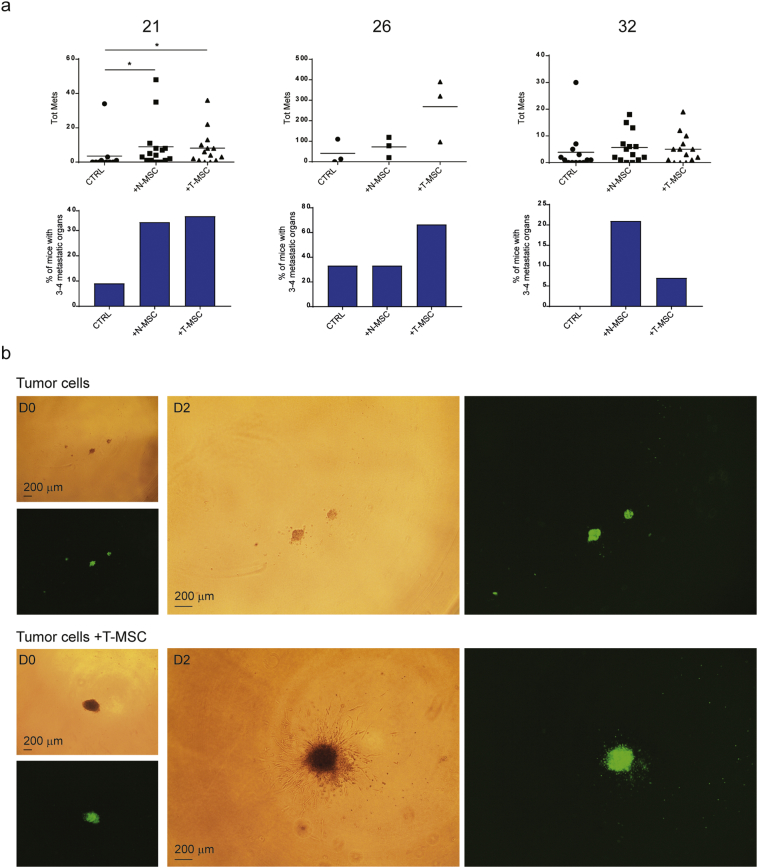
In vivo effects of N- and T-MSCs on primary lung cancer cells and MSC:tumor cell interactions in three dimensional structures.(A) Results from mouse injections with 21, 26 and 32 primary cancer cells alone (CTRL; n = 11, 3 and 13 mice respectively) or in presence of paired N- (n = 15, 3, 14 mice respectively) and T-MSCs (n = 14, 3, 14 mice respectively). For 21 and 32 tumors, 2 independent experiments were performed and data pooled together. Top panels: For each group of injection, total numbers of metastases per injected mouse are reported. Means are depicted by horizontal lines. Groups were compared using the nonparametric Kruskal-Wallis (K-W) test with post-hoc Dunn's multiple comparison test. Significant differences are reported and adjusted P-values indicated as * at P < 0.05. Lower panels: percentages of mice bearing metastases in 3–4 organs simultaneously in each group. See also Fig. S5. (B) Spheroids of CFSE-labeled tumor cells alone or mixed with T-MSCs from patient 21 at a 1:1 tumor:MSC cell ratio included in a 3-D matrix. Cell dissemination and three dimensional cell interactions were monitored by microscopy and the experiment performed in quadruplicate. One representative spheroid of tumor cells alone or mixed with T-MSCs is shown at day 0 and day 2 and images taken at 4× magnification by light and fluorescent microscopy. Scale bar = 200 μm. See also Fig. S6.